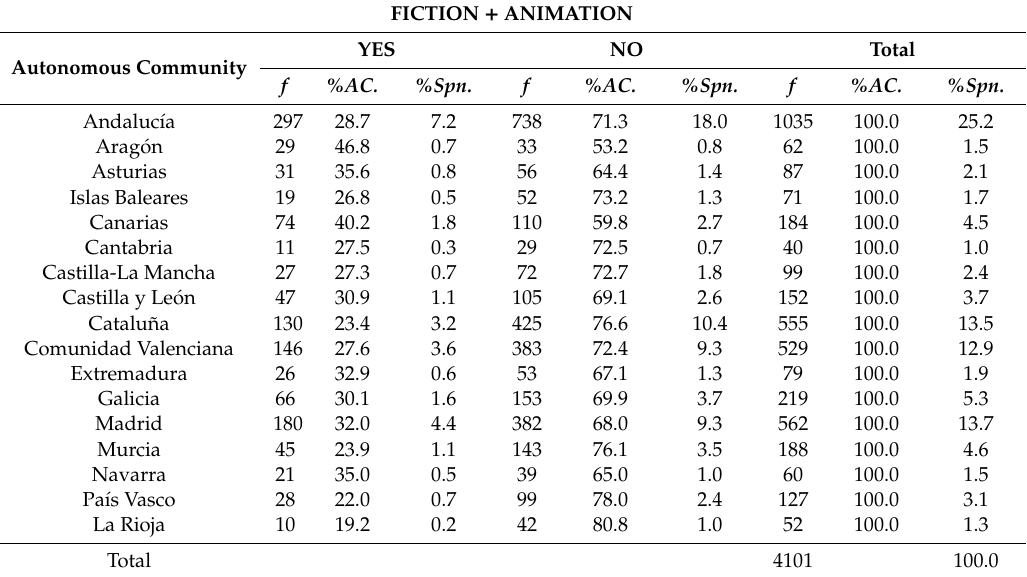
Table 8. Percentages and frequencies of fiction and animation films seen by teacher (cid:48) s degree students, according to the Autonomous